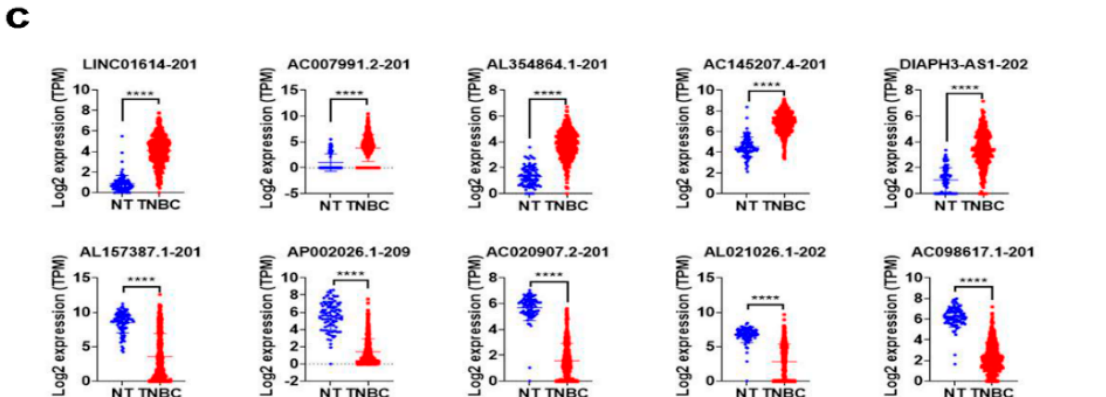
Figure 1. Differentially expressed lncRNAs in TNBC compared to normal breast tissue (NT). RNA-Seq data were aligned to the human geocode release v33, and the abundance of each lncRNA transcript was quantified. ( a ) Hierarchical clustering of TNBC (n = 360) compared to NT (n = 88). Each column represents one sample, and each row represents the lncRNA transcript. The expression level of each transcript (log2) is depicted according to the color scale. ( b ) Volcano plot depicting upregulated (red) and downregulated (blue) lncRNAs in TNBC compared to NT. ( c ) Scatter plot depicting the expression of the top 5 upregulated (upper panel) and downregulated (lower panel) lncRNA transcripts in TNBC compared to NT. **** p < 0.00001.